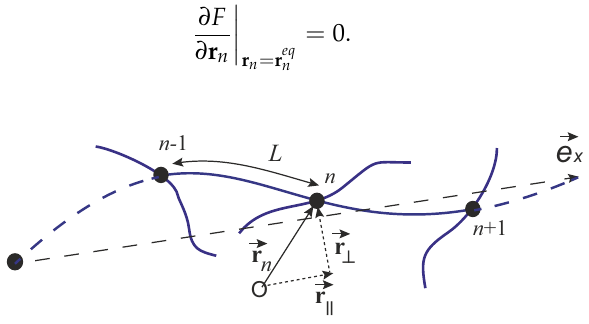
Figure 14. Sketch of an individual filament in a network of Broedersz et al. model